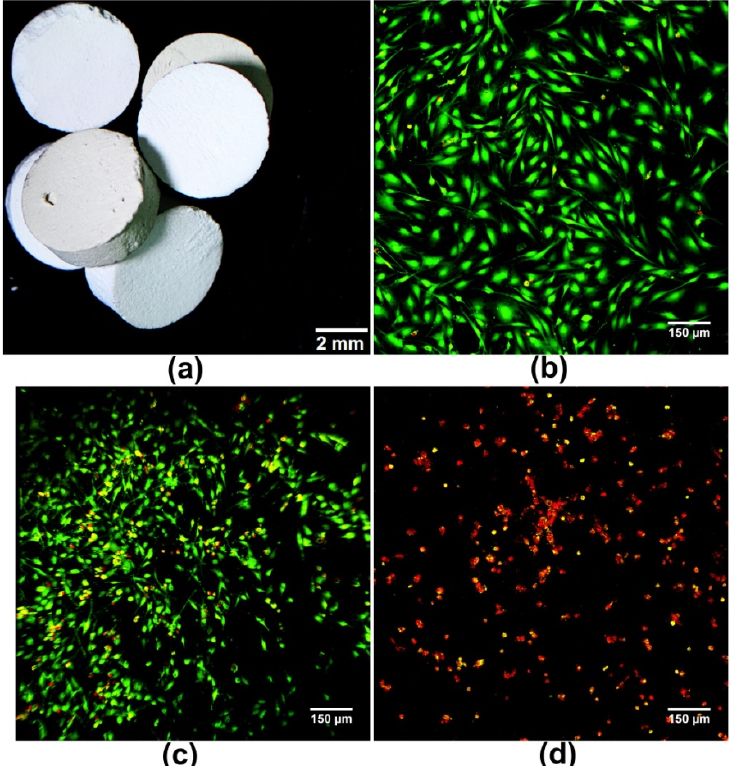
Figure 1. Cytotoxicity evaluation of antibacterial bone cements containing Ag-doped hydroxyapatite (HA): ( a ) shows fabricated bone cements; ( b ) shows control healthy MC3T3-E1 preosteoblasts cultured on polystyrene after live/dead staining; ( c ) and ( d ) show live/dead staining of MC3T3-E1 cells with reduced viability grown directly on the antibacterial bone cements with low ( c ) and high ( d ) concentration of Ag-doped HA [65] (green fluorescence—viable cells stained with calcein-AM, red fluorescence—nuclei of dead cells stained with propidium iodide).